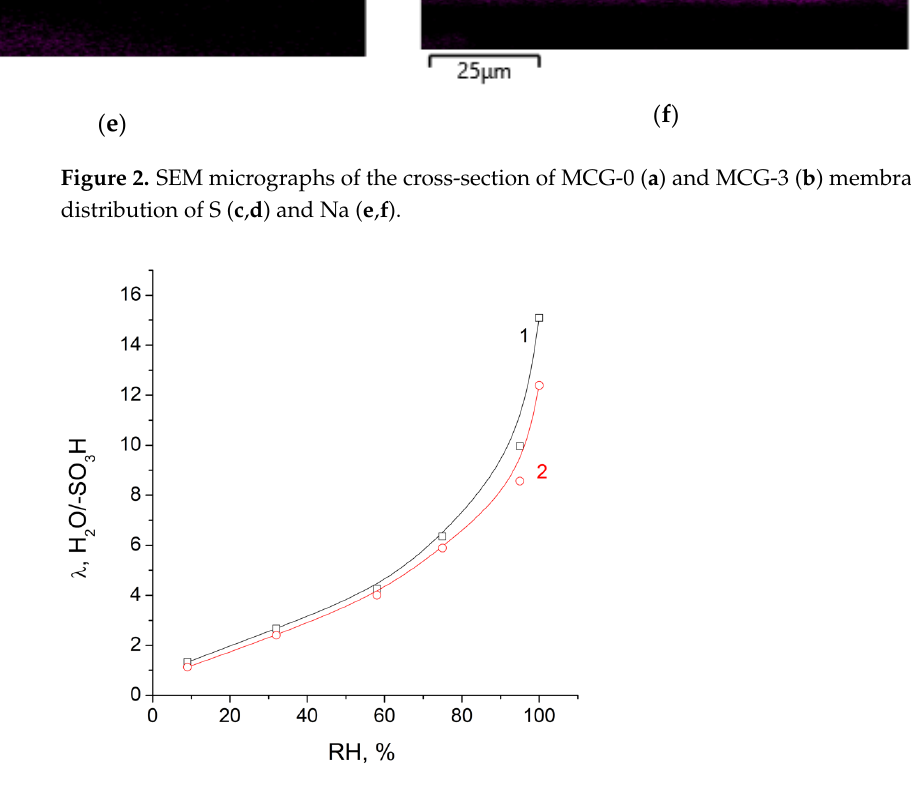
Figure 3. Dependence of the hydration numbers of MCG-0 (1) and MCG-3 (2) on the relative humidity (RH) at room temperature (100% humidity denotes the contact with water).